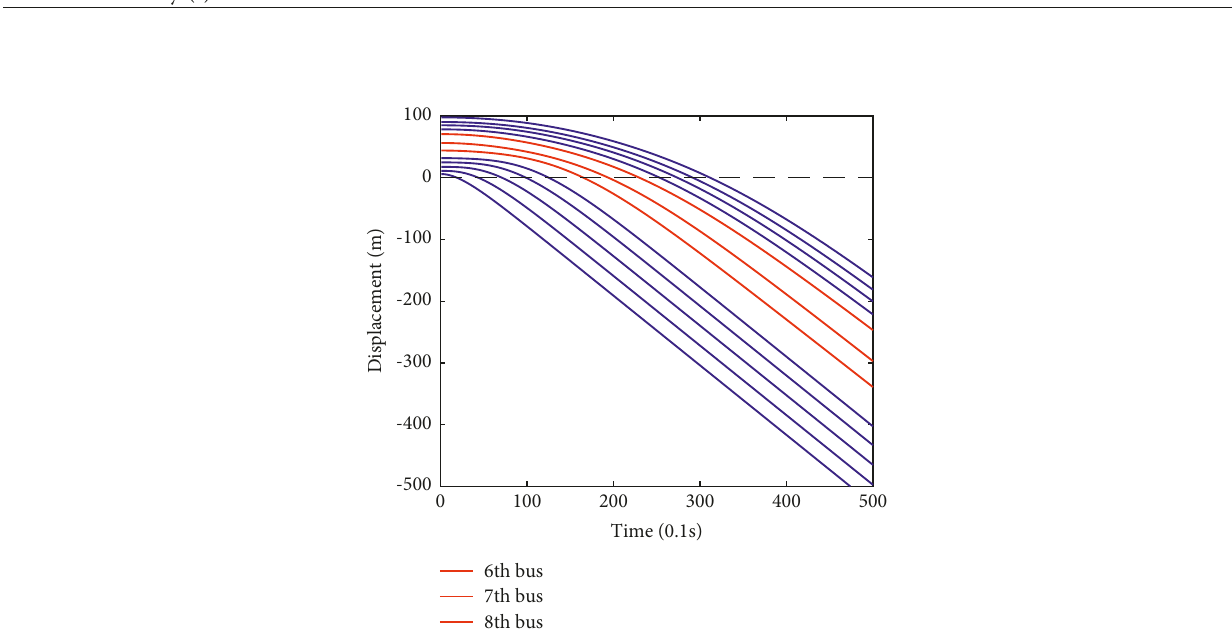
Table 5: The distribution of saturation headways with different positions of two buses in queue. Combination of bus positions Saturated headway (s)